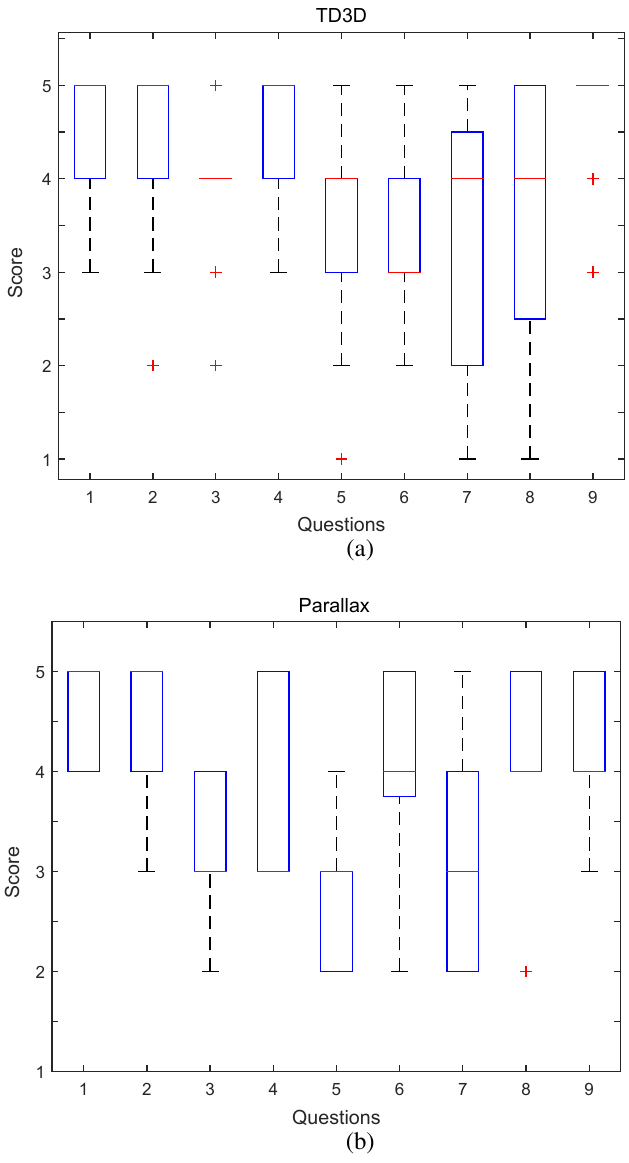
Fig. 5. Box plots of the scores given by the subjects to the 9 questions, for the “virtual holographic” display implemented through the TD3D stereoscopic technique (a), and a standard motion parallax technique (b). The red lines represent the median scores, the blue boxes are scores between the first and the third